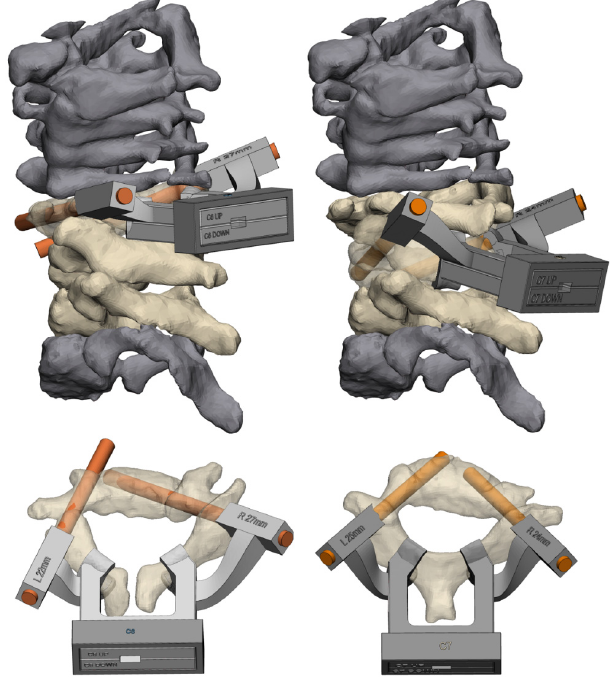
Figure 6. Click-on guide case 2. On the left side, the guide for C6; on the right side, C7. The orange cylinders are the target screw trajectories in the design. J. Pers. Med. 2022 , 11 , x FOR PEER REVIEW